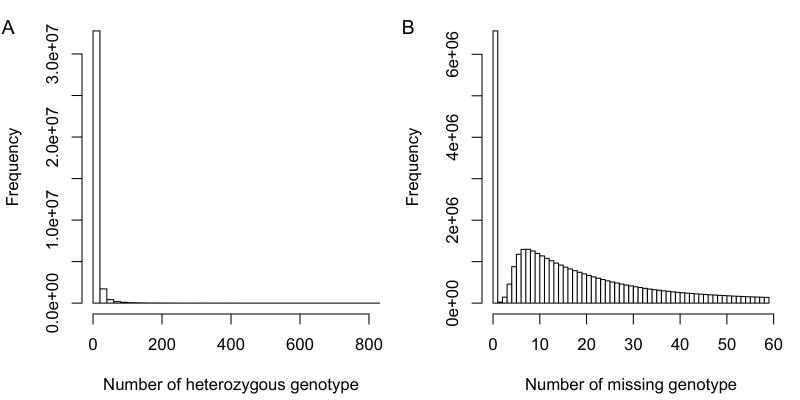
Frequency of the number of heterozygous genotype and missing genotype at 35,370,939 SNP sites among the 1210 maize lines.